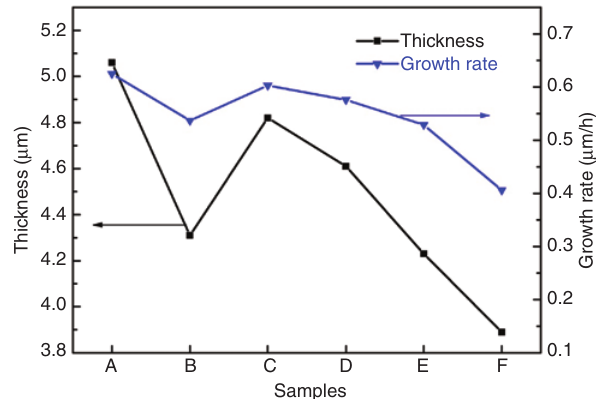
Figure 3: Thickness and growth rate for different